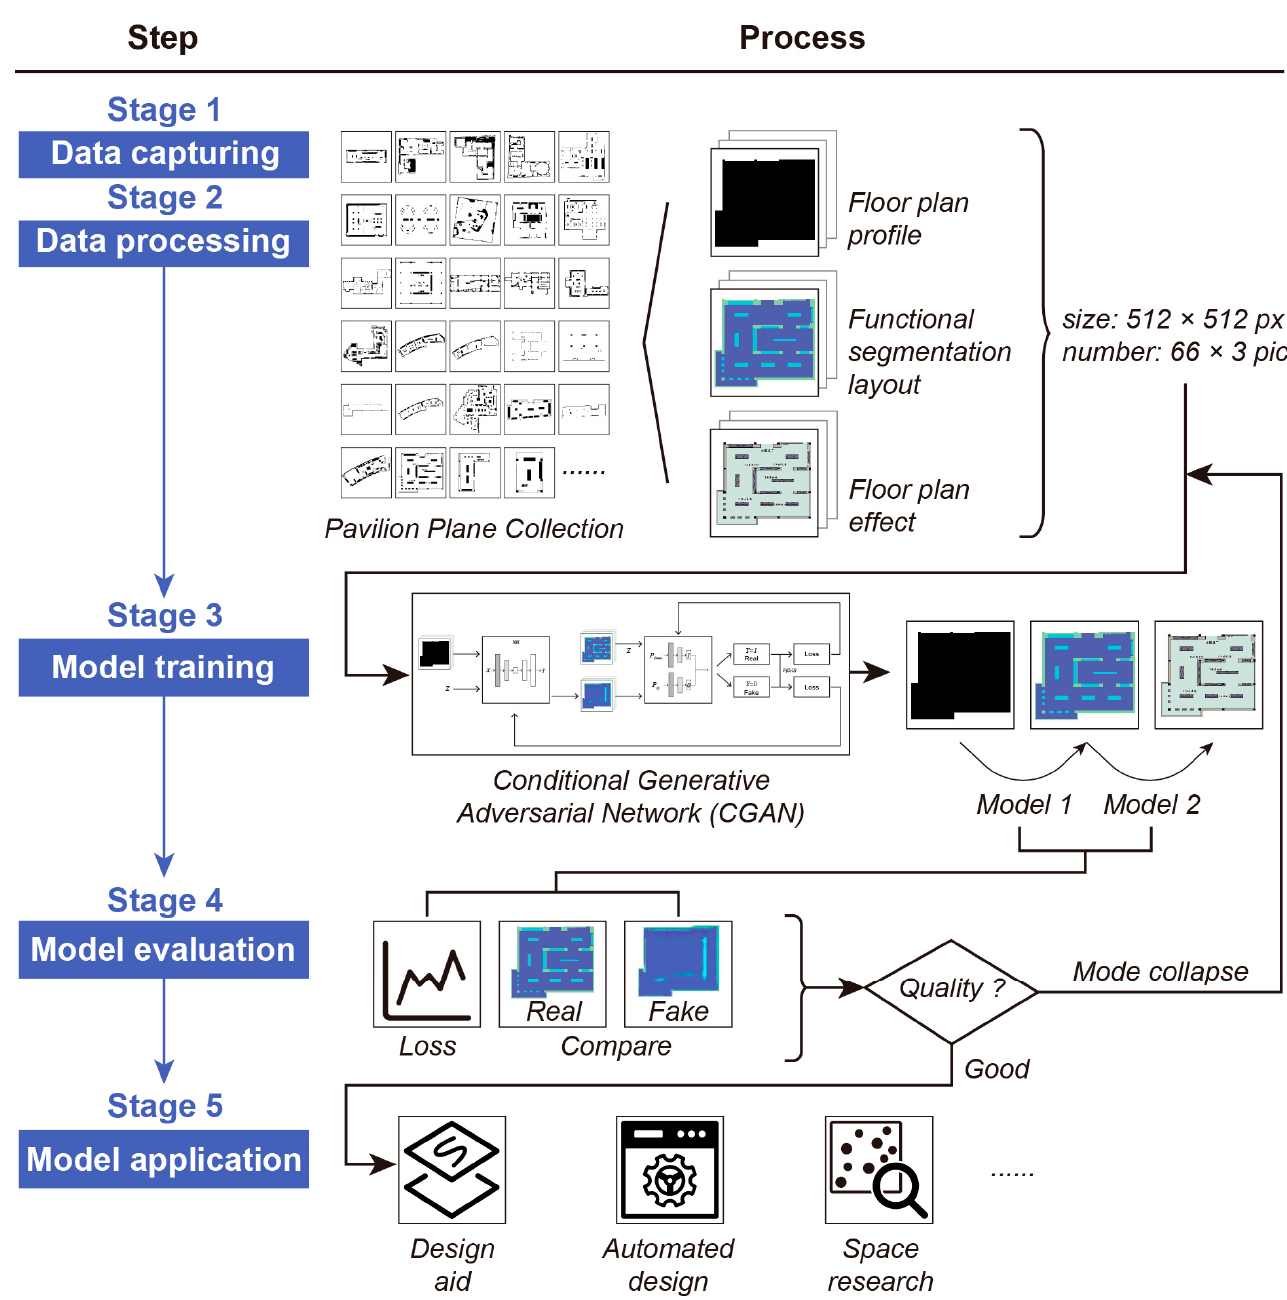
Figure 1. Research methods and